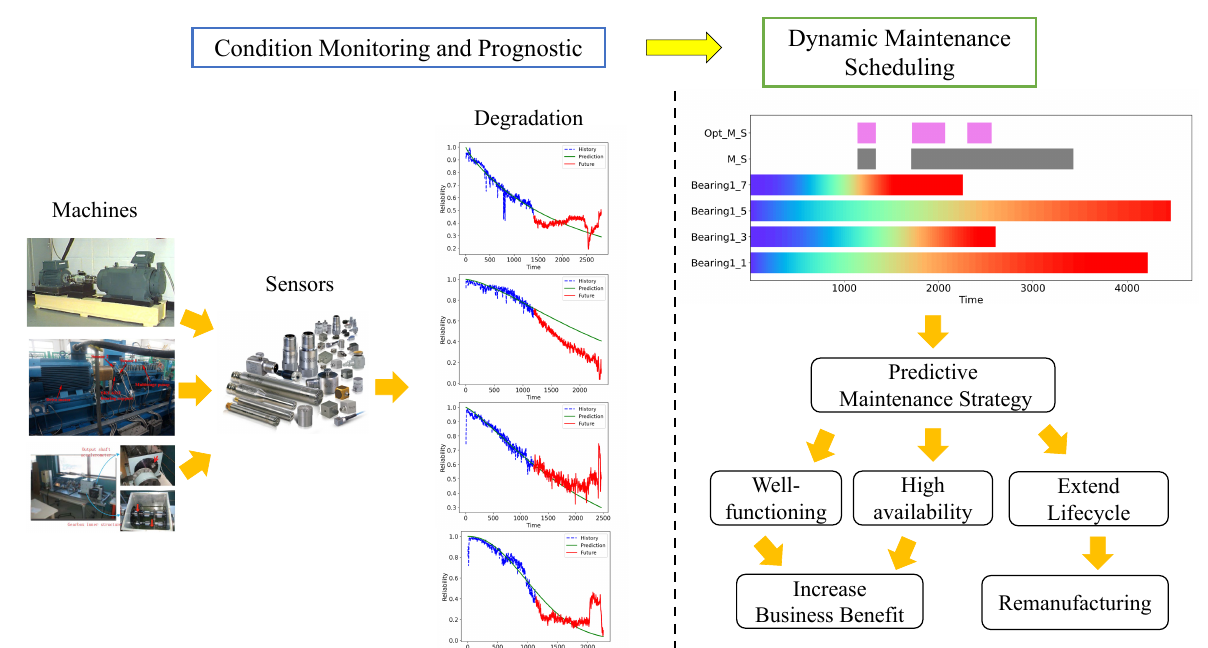
Figure 2. The overview of proposed predictive maintenance